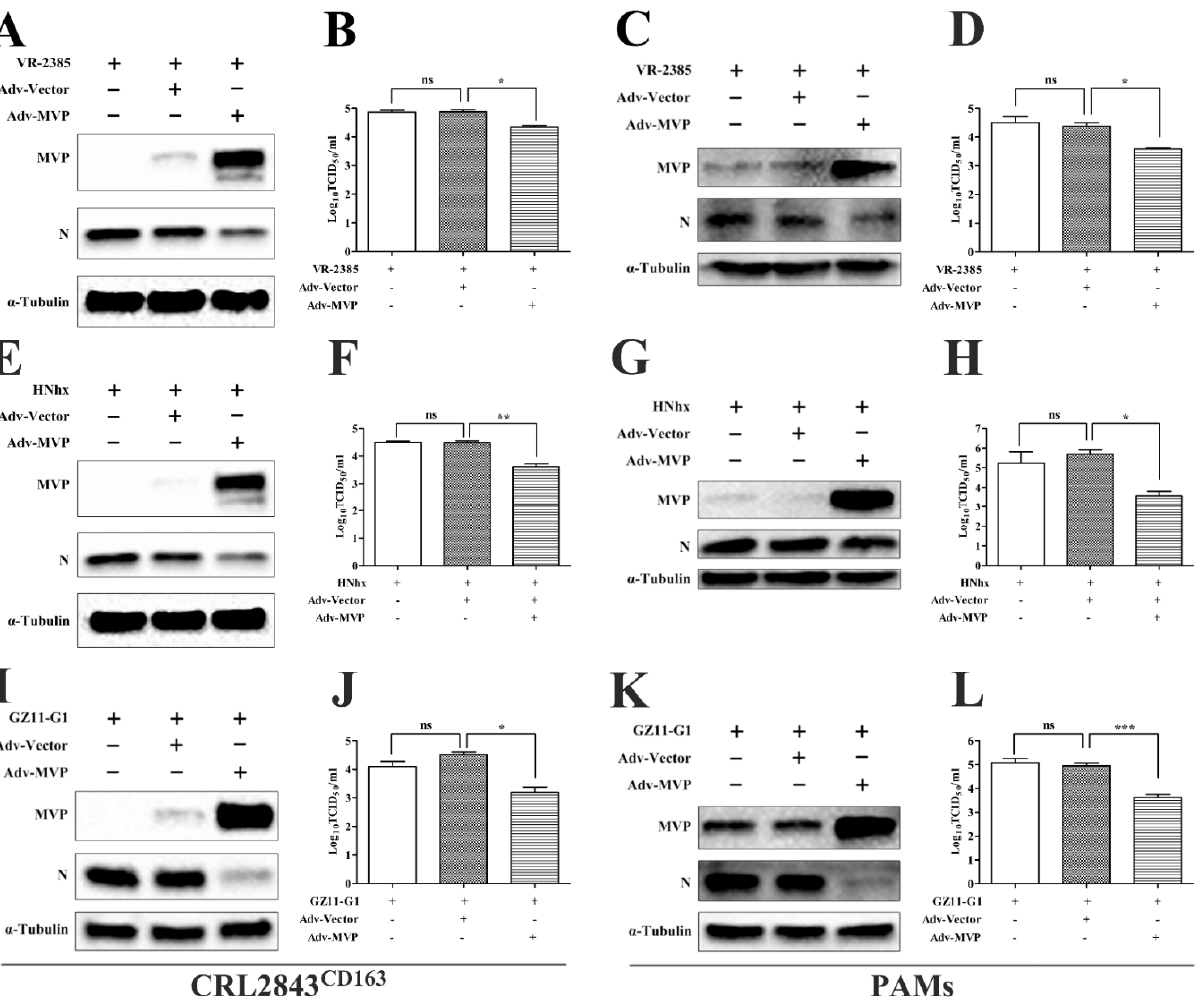
Figure 3. Inhibition effects of MVP on PRRSV replication are virus-strain-independent in CRL2843 CD163 cells and PAMs. CRL2843 CD163 cells or PAMs were infected with Adv − Vector or Adv − MVP (MOI = 5) for 24 h or 12 h, respectively. Then, CRL2843 CD163 cells or PAMs were infected with PRRSV at an MOI of 1 or 0.1 for 48 h or 24 h, respectively. The protein expression levels of MVP and PRRSV N were detected by Western blot ( A , E , I , C , G , K ). Virus titers from cell supernatants were measured by TCID 50 ( B , F , J , D , H , L ). The α -tubulin was used as internal loading controls in Western blot analyses. Data from three independent experiments are expressed as the means ± SD. The analysis of differences between the means was performed using ANOVA and is marked by ns (no significant), * ( p < 0.05), ** ( p < 0.01) and *** ( p < 0.001).